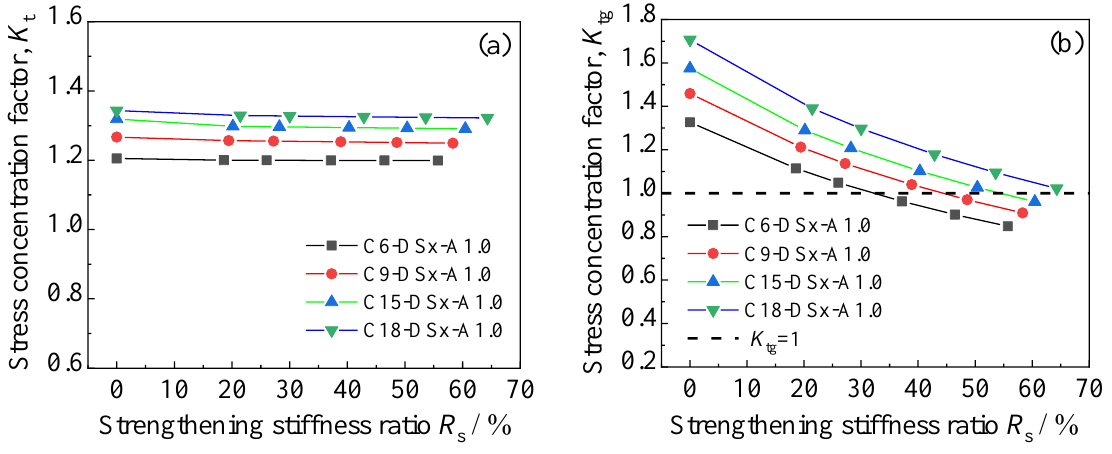
Figure 16. Influence of strengthening stiffness ratio on the stress concentration factors ( a ) K t and ( b ) K tg of the corroded steel plates strengthened with CFRP plates.